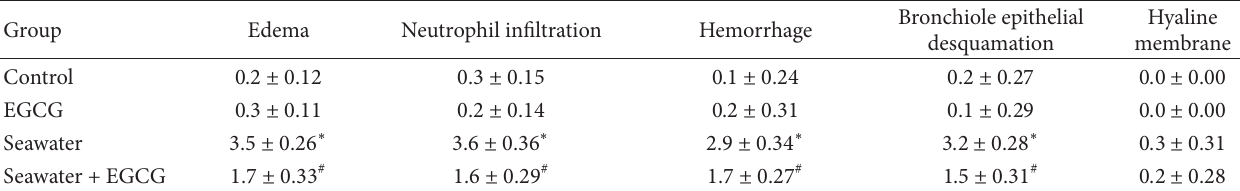
Table 1: Effects of EGCG on the assigned lung injury scores in seawater aspiration-induced ALI.